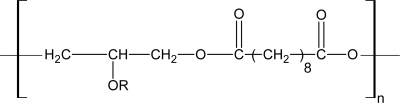
Structure of PGS [19].